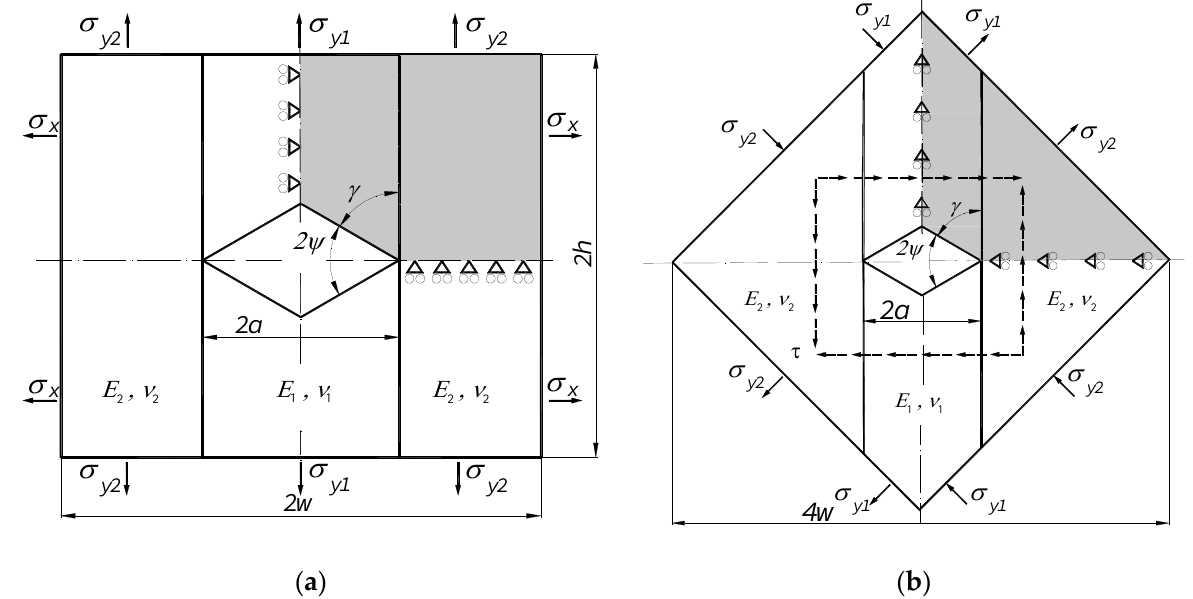
Figure 4. Geometry method of fixing and loading of specimens with a centre-notched plate subjected to ( a ) uniaxial/biaxial tension and ( b ) pure shear loading.